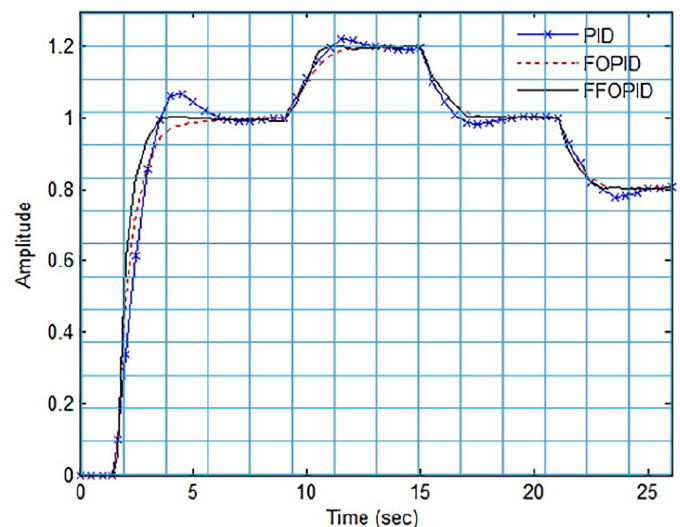
Figure 8. Change in set-point different controllers’ response of change in set-point.